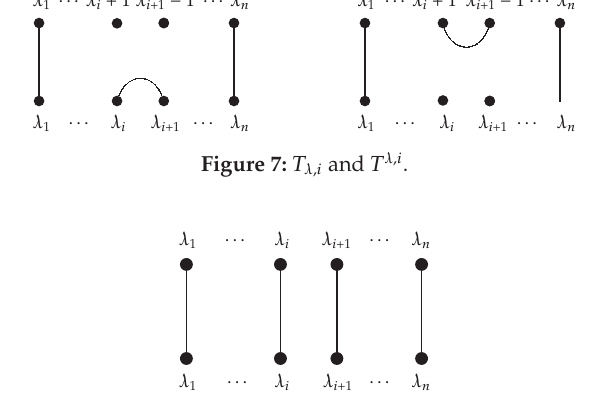
Figure 6: D λ,i and D λ,i .